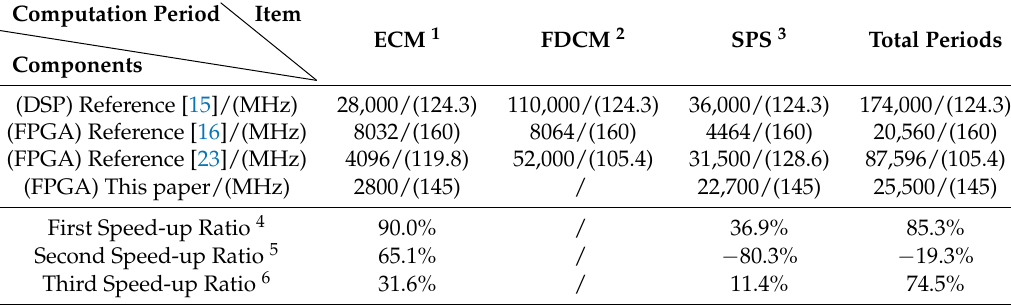
Table 3. Comparison among different